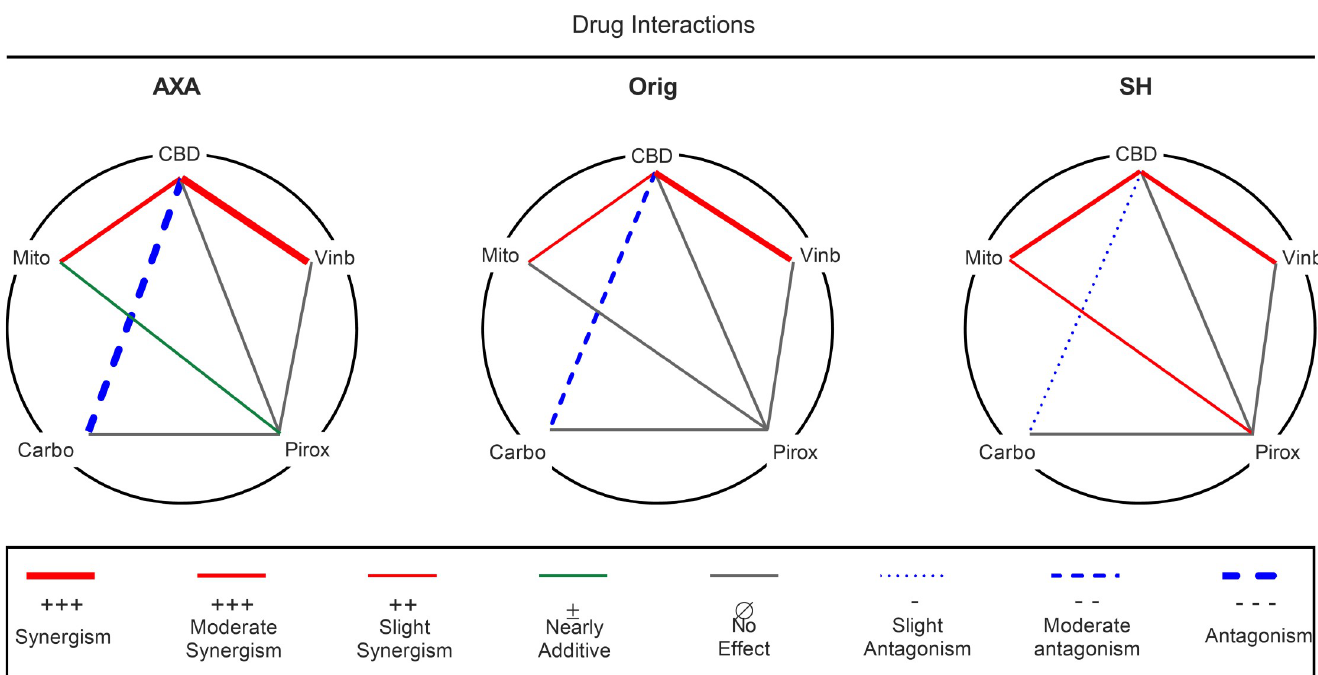
Fig 5. Polygonogram showing drug interactions of 5 drugs in combination with CBD or piroxicam in canine UC cell lines. Drug combinations are connected by lines, where synergism is indicated by solid red lines and thickness dictates the degree of synergism; heavy (CI = 0.1–0.5, synergism), medium (CI = 0.5–0.8, moderate synergism), and thin (CI = 0.8–0.9, slight synergism). Antagonism is indicated by blue broken lines, where thickness dictates degree of antagonism; heavy (CI > 2.0, antagonism), medium (CI = 1.5–2.0, moderate antagonism), and thin (CI = 1.1–1.5, slight antagonism). Additive is indicated by a green line (CI = 1.0) and no effect is indicated by grey solid lines (no enhancement in